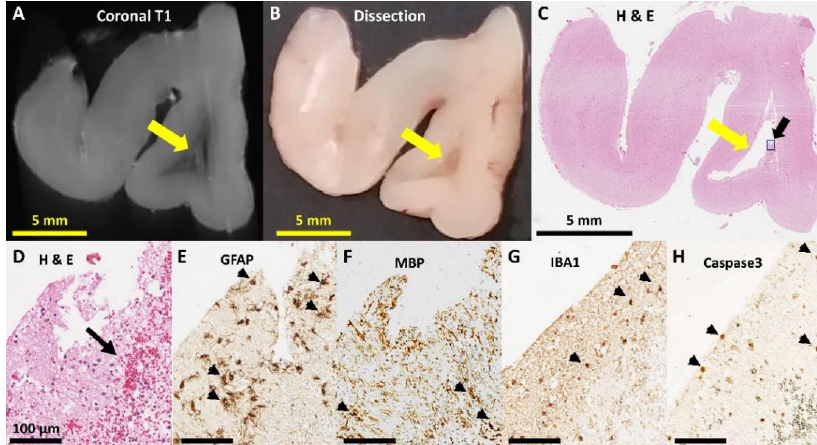
Figure 8. Frontal cortex lesion examined using MRI, dissection, histology and immunohistochemistry. The large white matter lesion (yellow arrows) are observed in the coronal plane of the prefrontal cortex with A ) T1-weighted MRI image, B ) dissection, and C ) H&E staining. Close examination of the lesion indicated by boxed region and black arrow in C ) reveals red blood cells with H&E staining in the lesions site (arrows in D ), local changes in GFAP+ astrocyte morphology (arrows in E ), fragmentation of myelin (throughout tissue) and intense oligodendrocyte staining with MBP (arrows F ), intense local microglia staining (arrows in G ), and localized apoptosis indicated with Caspase 3 staining (arrows in H ).